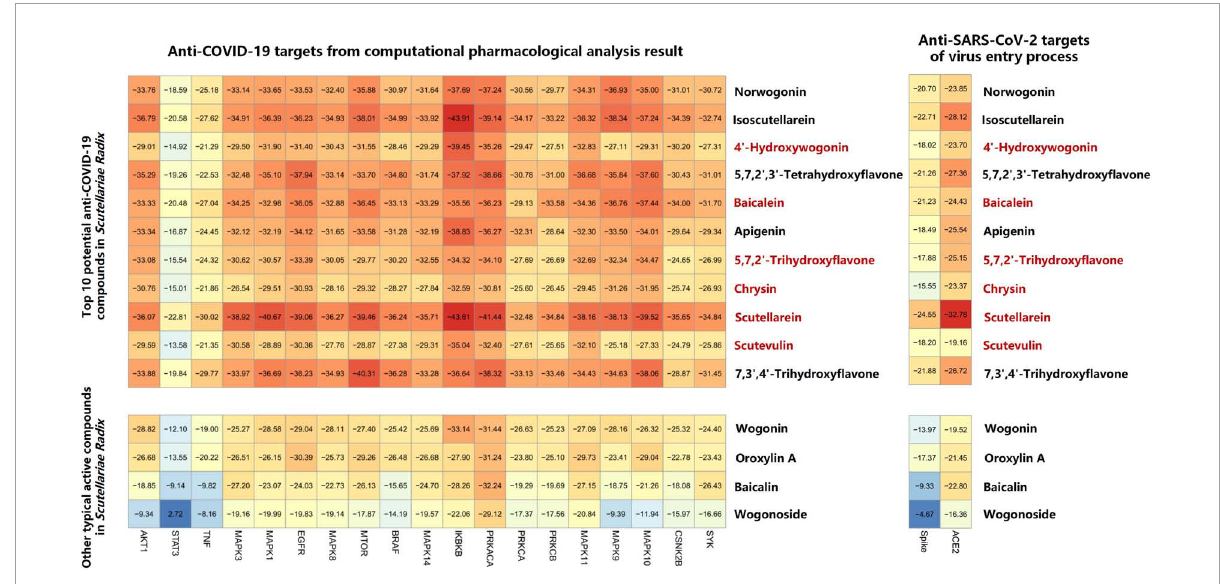
FIGURE5 Heatmap of molecular docking analysis The top 10 potential active compounds that can be detected by LC-MS in Scutellariae radix were marked in red.